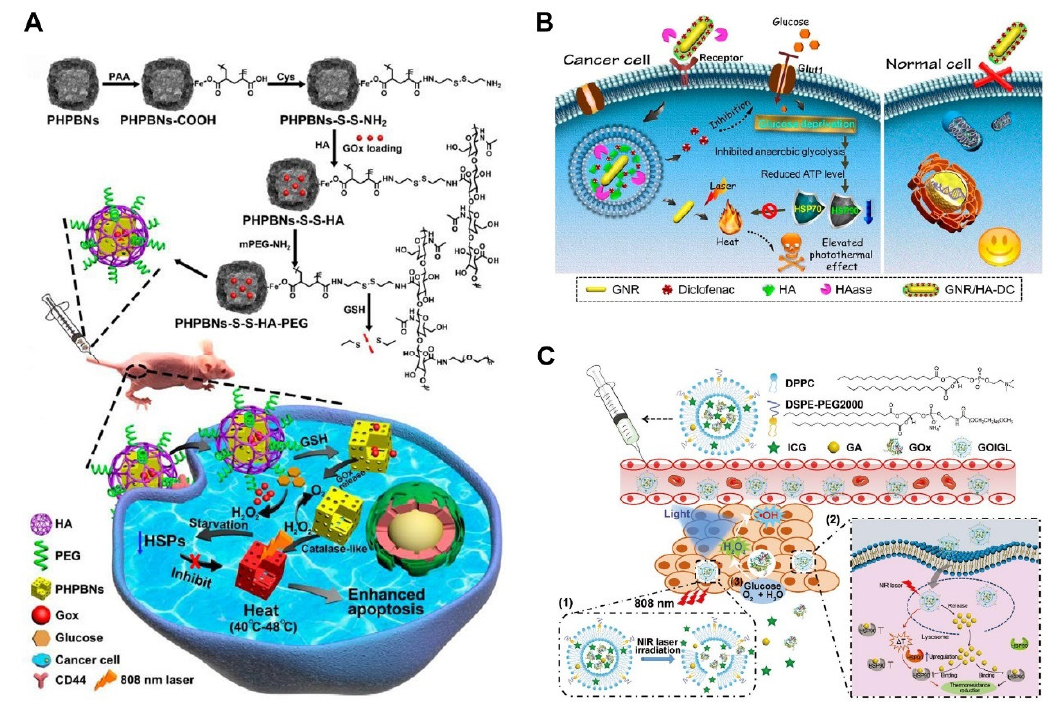
Figure 6. Strategies that enhance the therapeutic effect of MTPTT through inhibiting energy or metabolism. ( A ) Illustration of GOx-induced starvation for enhanced MTPTT in a hypoxic TME via the PHPBNs-mediated tumor reoxygenation [29]. Copyright © 2022, American Chemical Society. ( B ) Schematic illustration of thermosensitive liposomes encapsulating GOx, ICG, and GA for syn- ergistic starvation therapy, EEPT, and enhanced MTPTT of tumors [91]. Copyright © 2022 John Wiley and Sons. ( C ) Schematic illustration of GNR/HA-DC for selectively sensitizing tumor cells to MTPTT by interfering with the anaerobic glycolysis metabolism [92]. Copyright © 2022, American Chemical